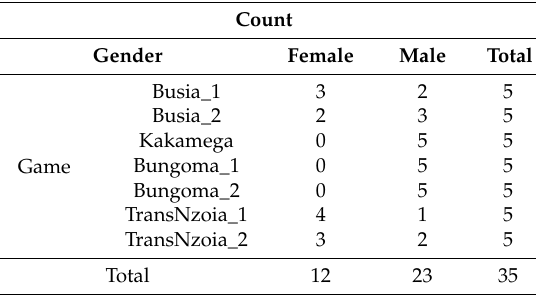
Table A5. Game * Gender crosstabulation.